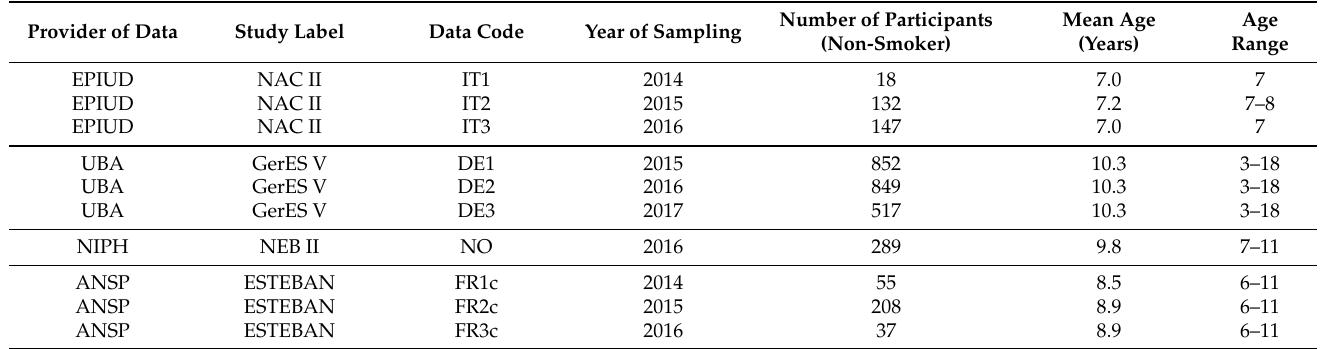
Table 1. Overview of HBM4EU-aligned studies and data sources based on bilateral agreements performing biomonitoring acrylamide metabolites, performed between 2014 and 2017 in teenagers and children.